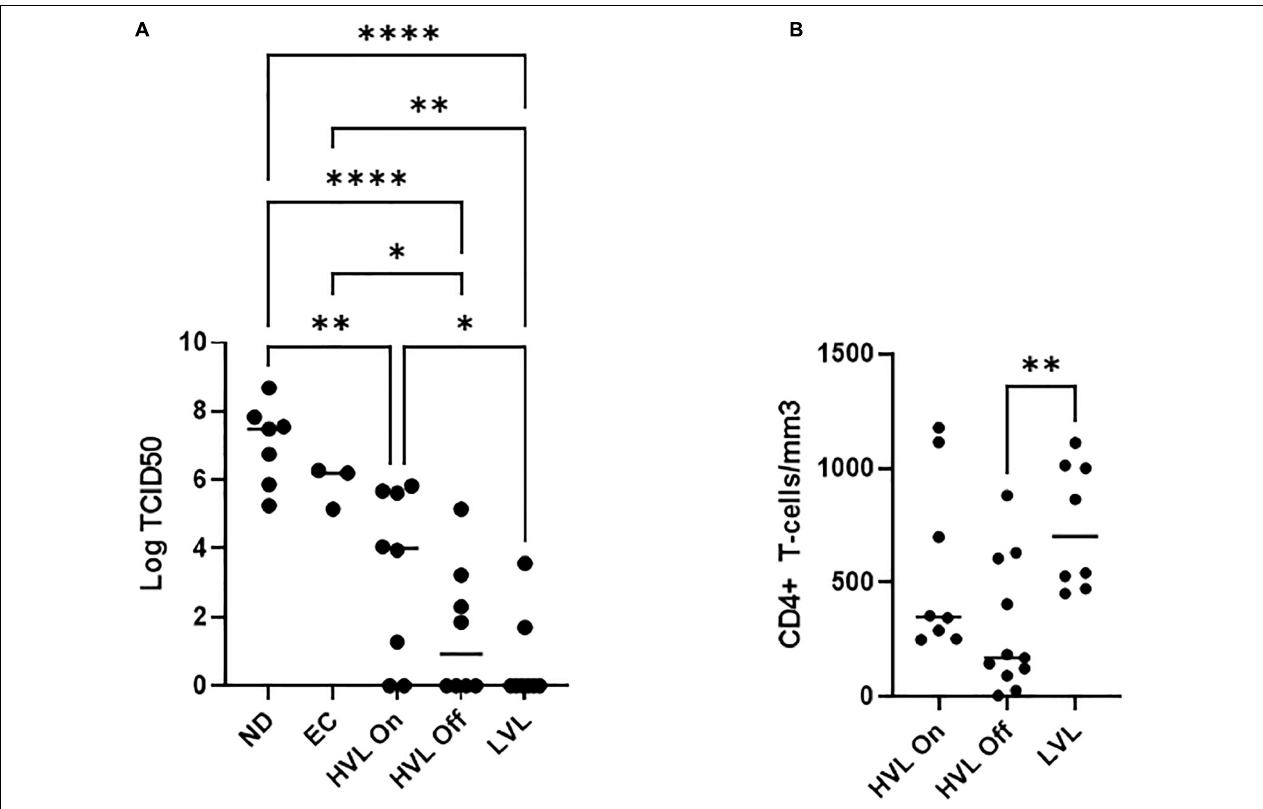
FIGURE 1 | PBMCs from different classes of HIV-1 infected individuals show different susceptibility to de novo infection. (A) Limiting dilutions of NL4-3 were used to infect arrays of PBMCs from normal donors (ND), elite controllers (EC), high viral load on or off therapy (HVL On, HVL Off), or low viral load (LVL) donors in 96 well plates. p24 ELISA was used to determine productive infection in a given well and TCID50 was calculated. One-way ANOVA with Tukey’s multiple comparison was performed. P -value: ∗ < 0.05, ∗∗ < 0.01, ∗∗∗∗ < 0.0001. (B) CD4 + T-cell counts in the blood of HVL (on/off therapy) and LVL. Mann-Whitney test was used to compare groups ∗∗ P <